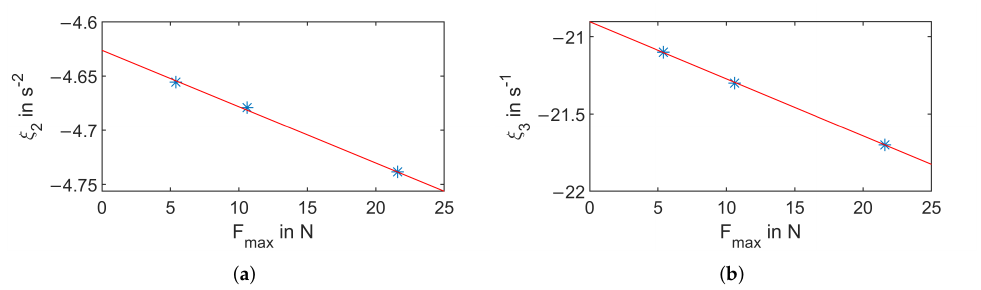
Figure 18. Linear dependency of the identified coefficients ( a ) ξ 2 und ( b ) ξ 3 on the excitation force F max